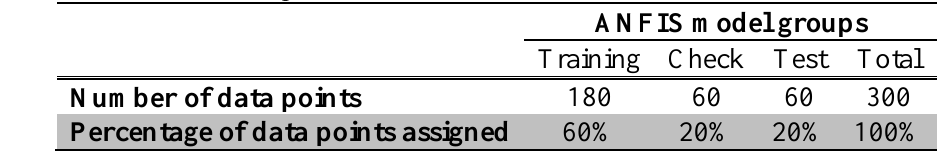
Table 2 Proportions of Data in Each